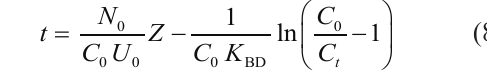
nanoparticles packed bed 2